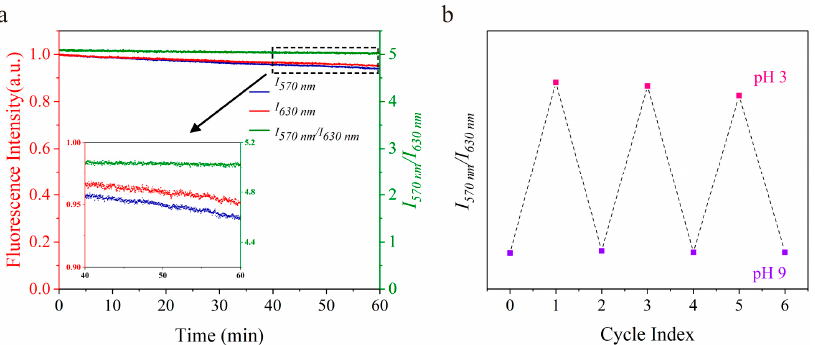
Figure 6. The photostability and reversibility of the nanosensors. ( a ) The nanosensors were in BR buffer (pH = 3). The fluorescence intensity was normalized. ( b ) The solution of nanosensors in continuous sensing of 1 M HCl/NaOH for three cycles.